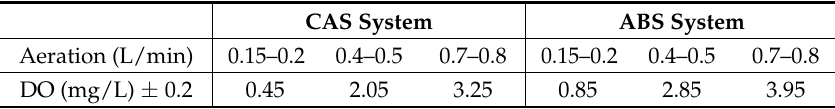
Table 3. Operating parameters for